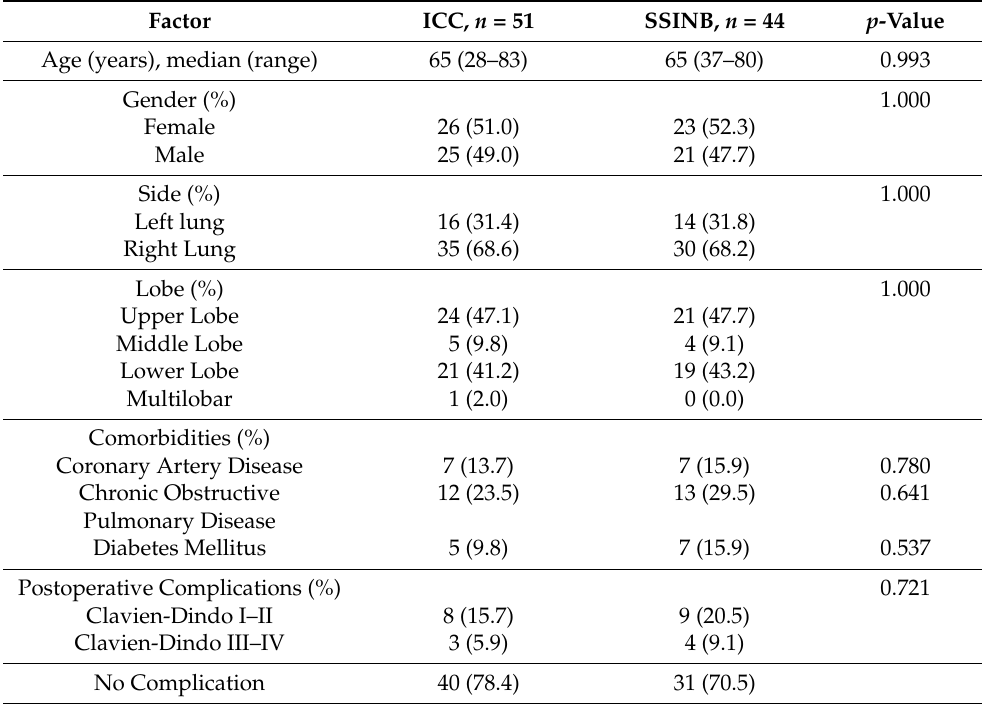
Table 1. Patient